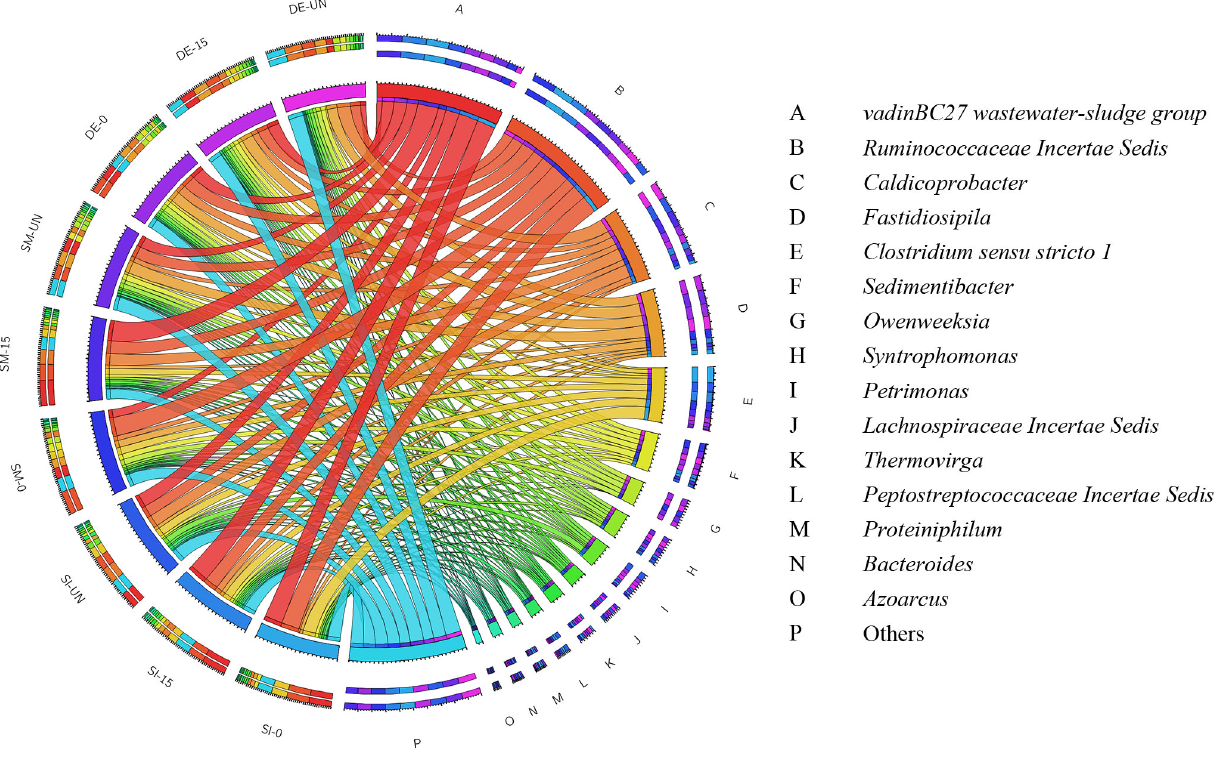
Frontiers in Microbiology |